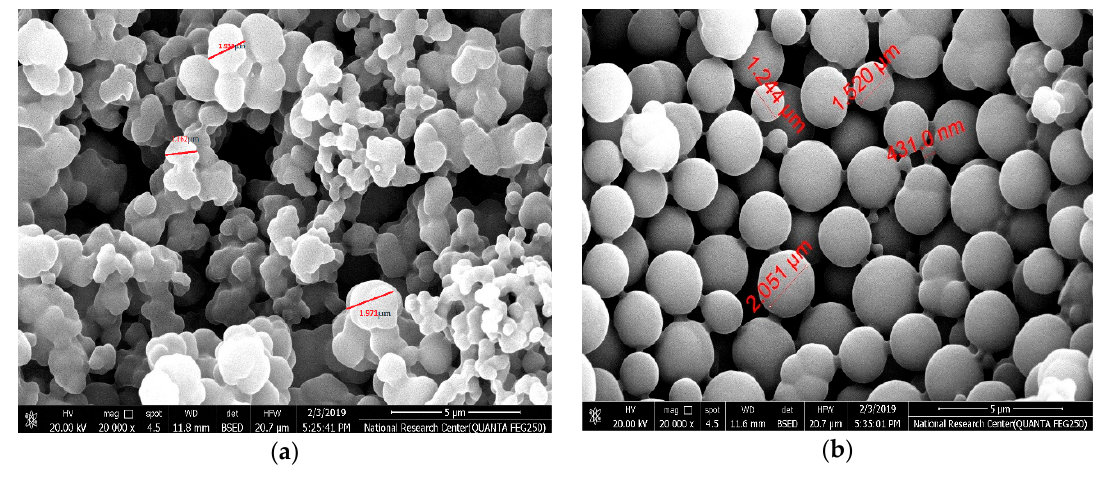
Figure 3. SEM images of ( a ) MIP and ( b ) NIP beads.